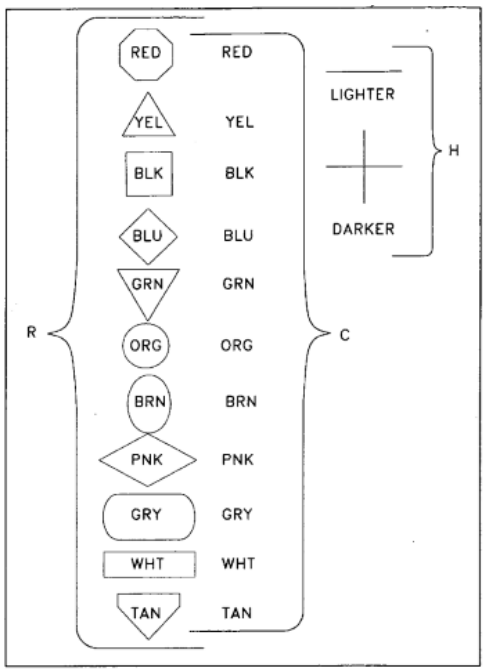
Figure 4. Gagne Todd system. Source: Todd,